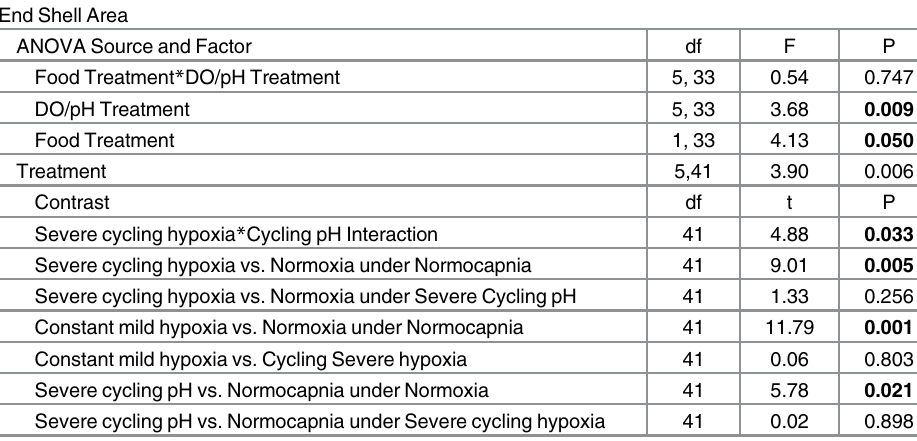
Table 9. 2014 juvenile oyster growth